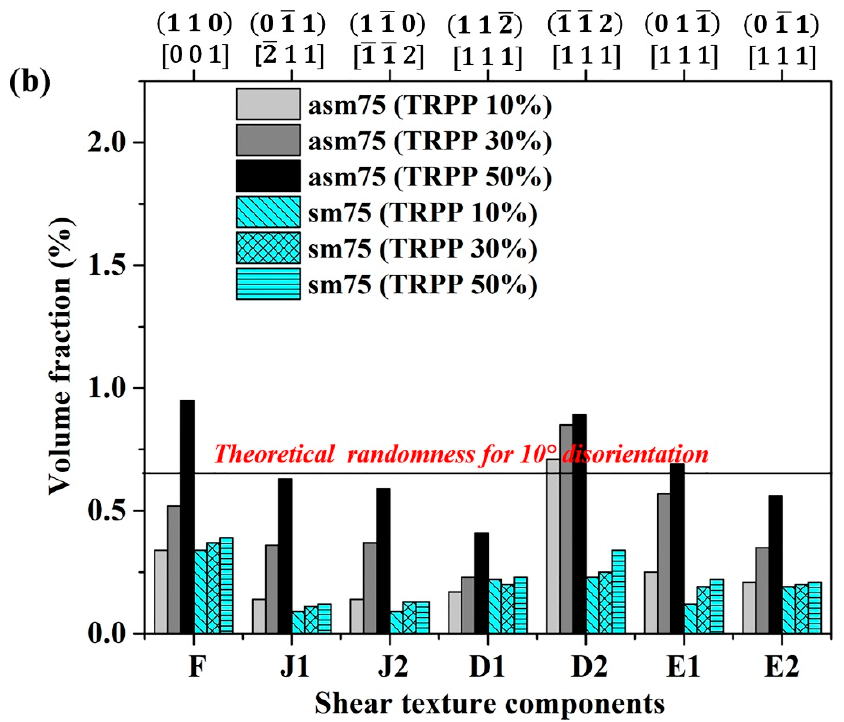
Figure 4. Volume fractions of the prominent ( a ) rolling and ( b ) shear texture components at mid ‐ thickness in multi ‐ pass symmetric and asymmetric (1:2) rolling in medium strain range (75%).